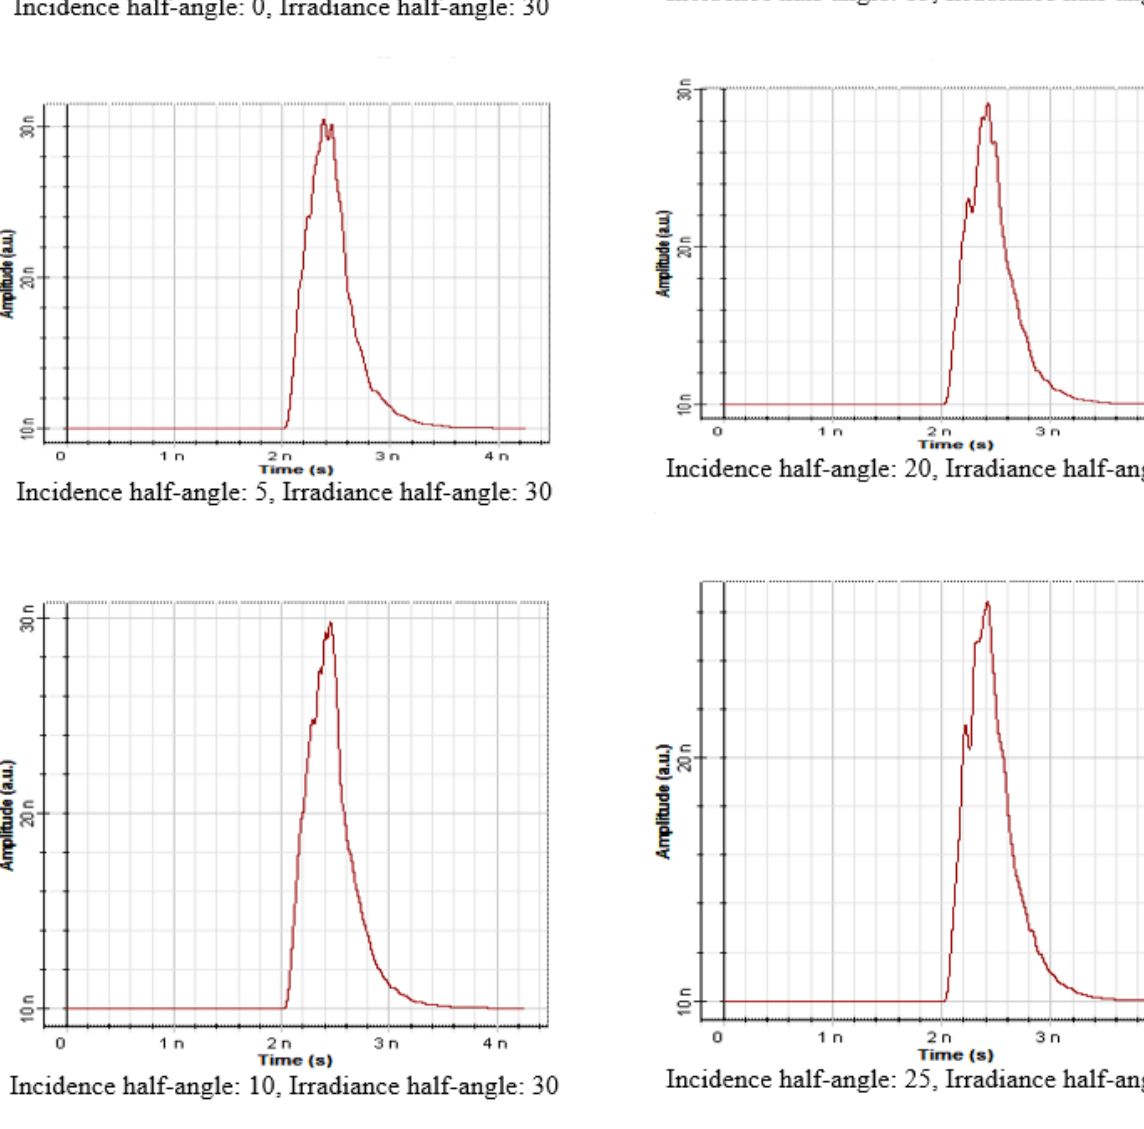
Figure 17. Incident angle ( θ d ) effect on the LOS propagation model ( θ d changes from 0 ◦ to 25 ◦